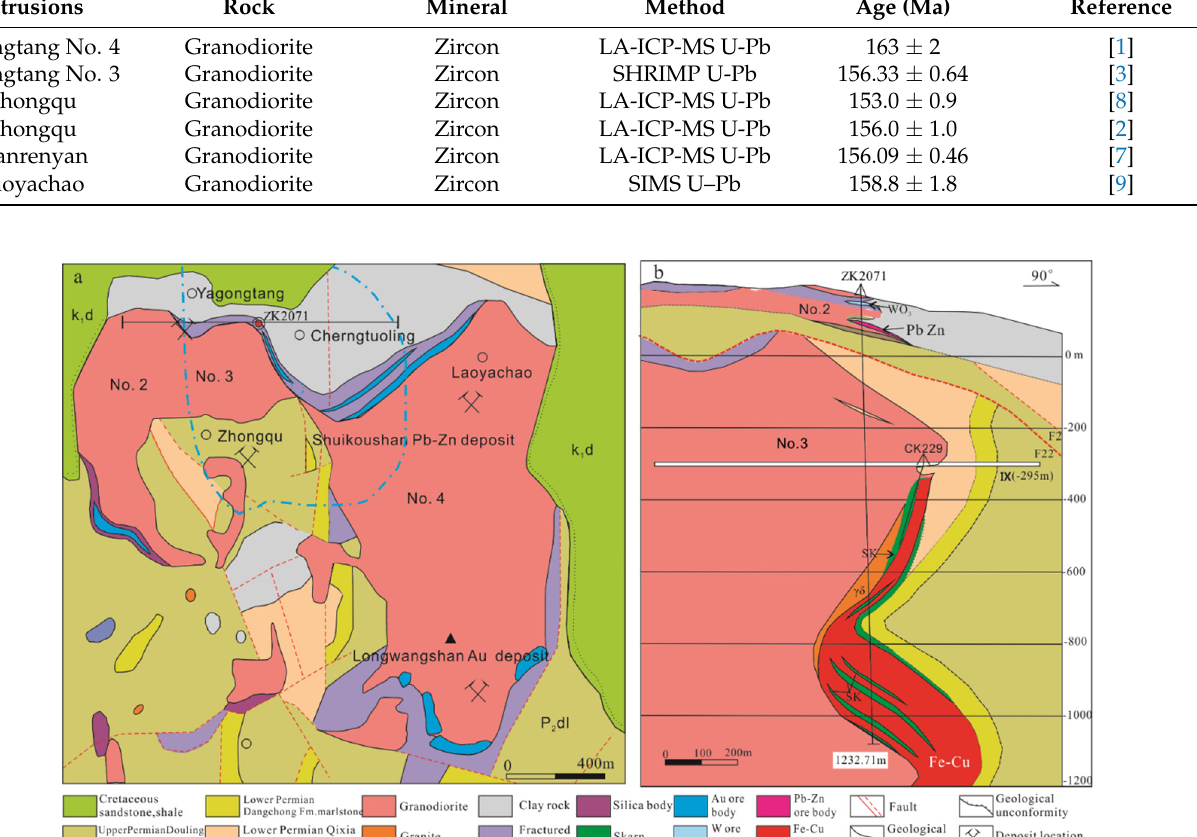
Table 1. Ages of several mineralized intrusions in the Shuikoushan ore field.